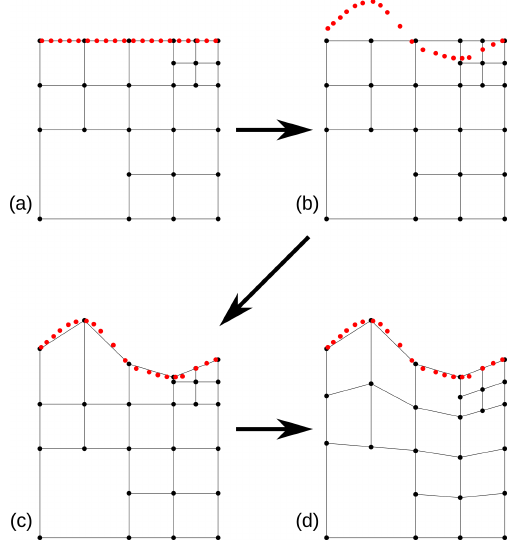
Figure 3. Process for the update of the free surface (the motion is exaggerated for the sake of the explanation and is less extreme in reality). (a) Initial state where the velocity is computed on the grid. (b) The point swarm tracking the free surface is advected accord- ing to the computed velocity. (c) The grid nodes at the top of the free surface are moved vertically to match the point swarm. (d) The deformation of the grid is diffused to the rest of the nodes.